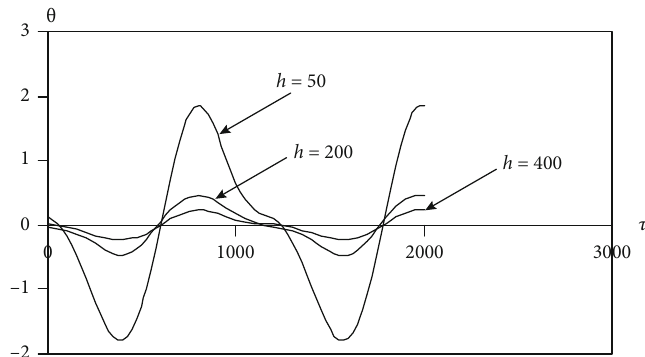
Figure 4: The analytical and numerical solutions θ against τ at h = 400 , 200, and 50.